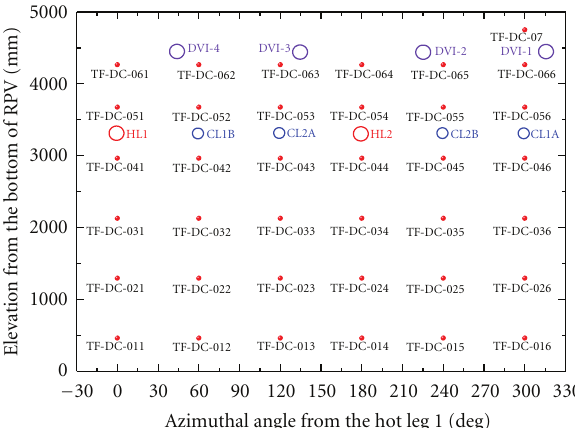
Figure 14: Measurement locations for downcomer fluid tempera-